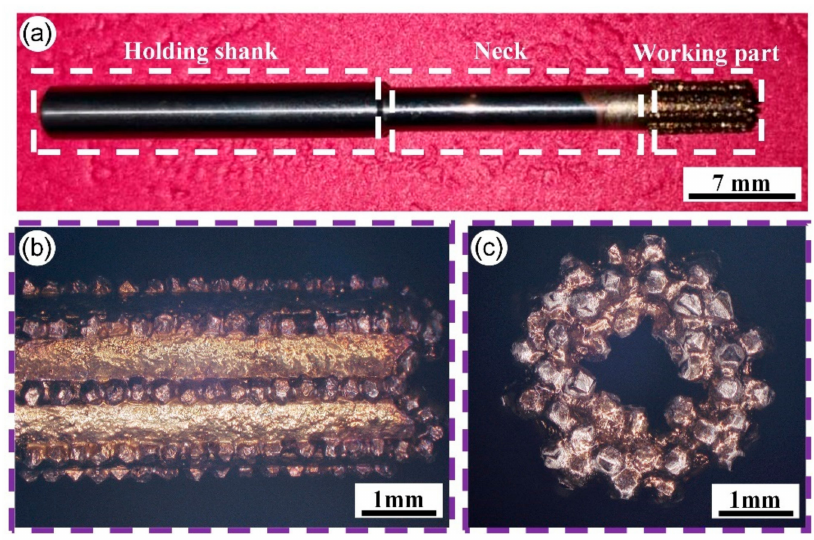
Figure 2. An orderly arranged brazed diamond core drill, ( a ) the composition of tool, ( b ) the side abrasive of tool, ( c ) the top abrasive of